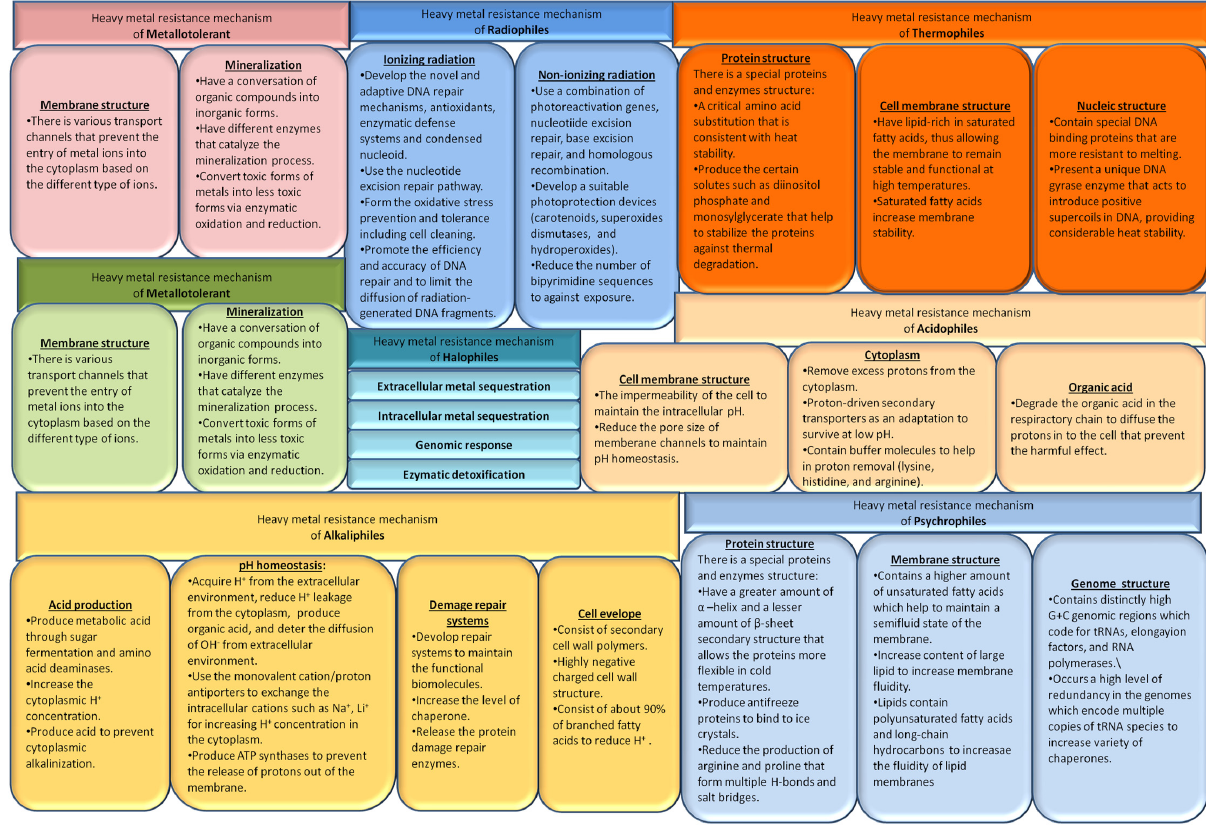
Figure 4. Mechanisms of the resistance of extremophiles .